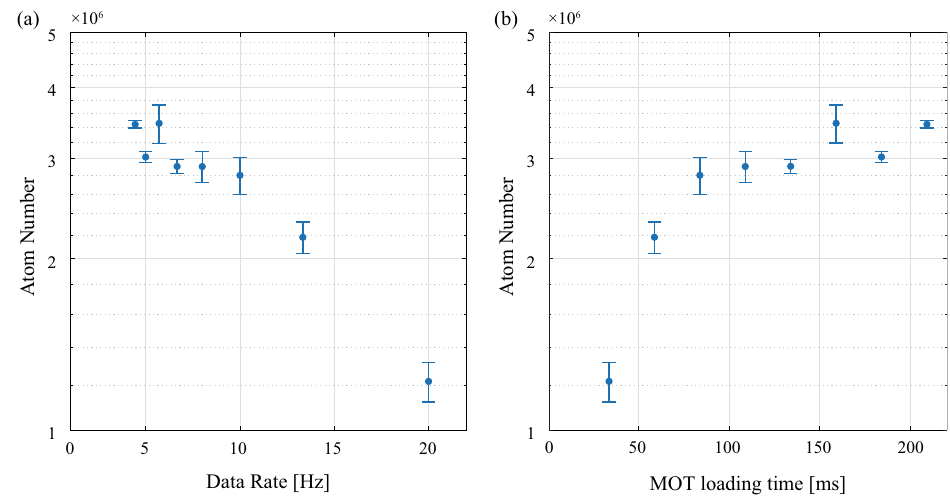
Fig. 6 Measurement data rate and loading time of GMOT operation, including sub-Doppler cooling process. a Plot of atom number versus measurement data rate of GMOT operation. b Plot of atom number versus MOT loading time. Error bars are standard